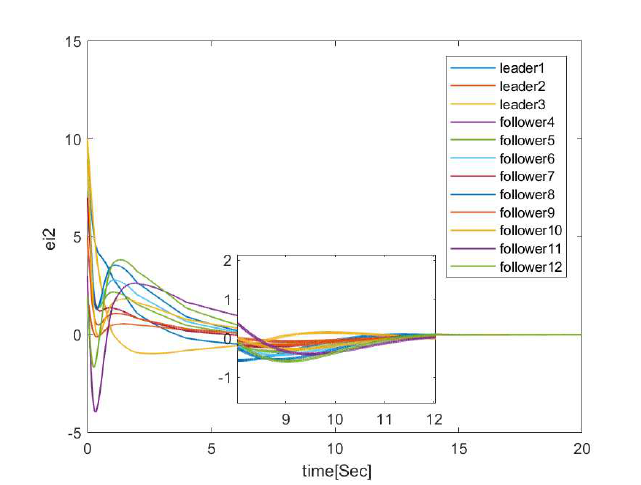
Figure 3. Position State Component 2 of Agent without delay.